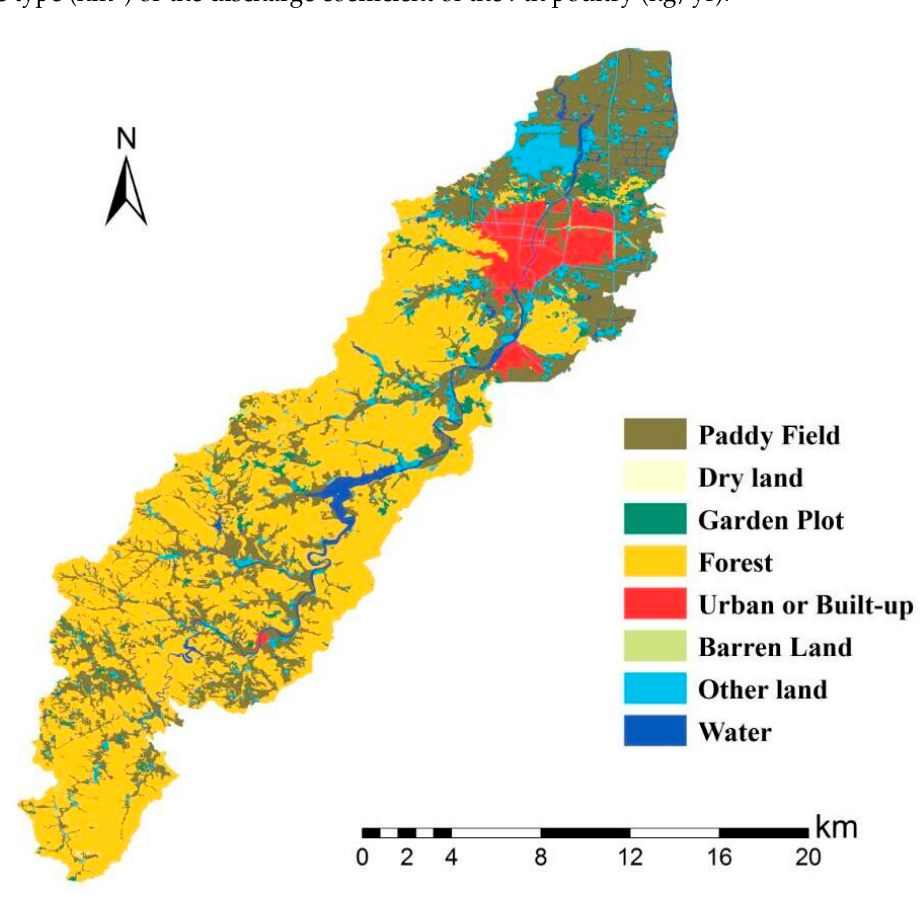
Figure 4. The land use and land cover of Xian-Jiang basin in 2015.